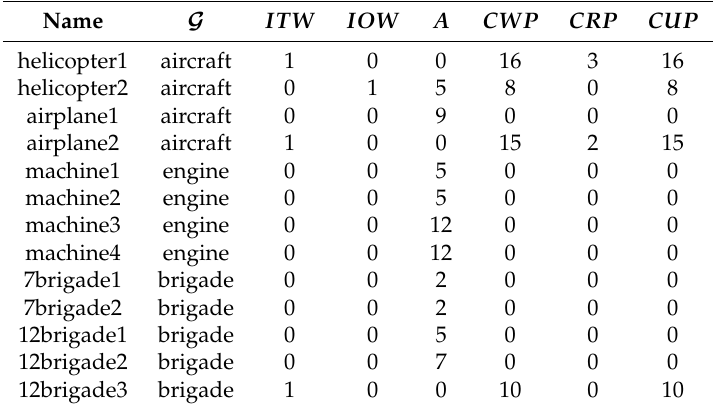
Table 2. Parameters associated with the initial disposition of resources (abbreviations are defined in Section 2.1).